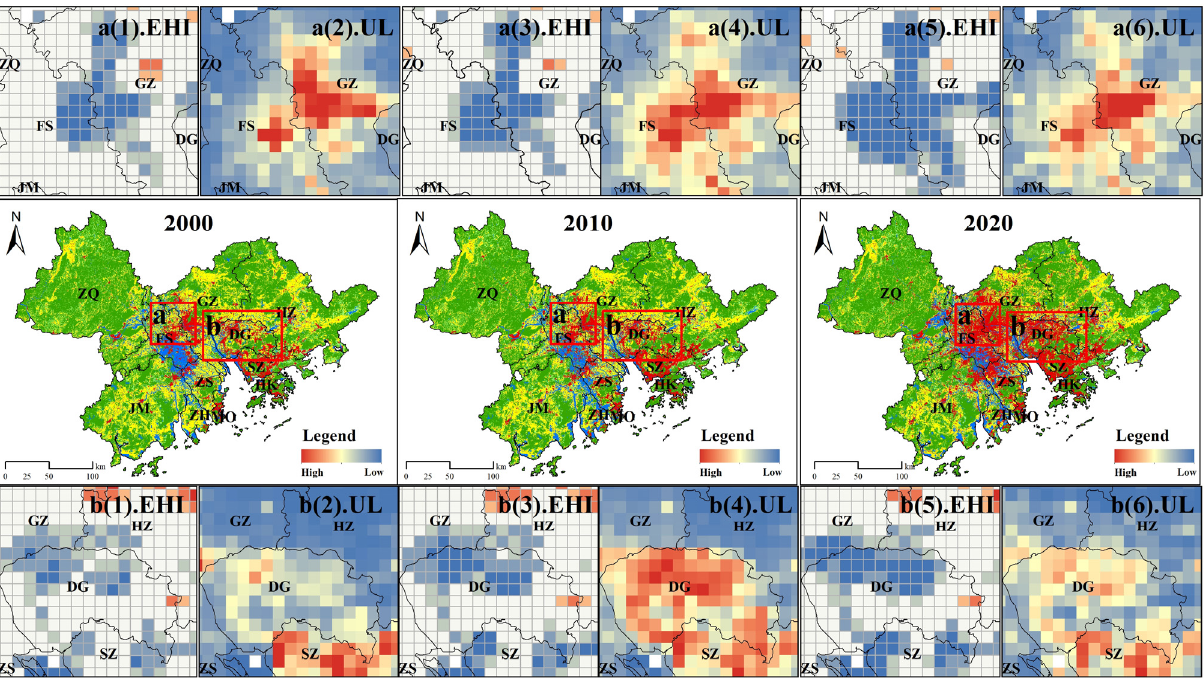
Figure 10. Changes in the EHI and UL in the core urban junction in the GBA, 2000–2020. Note: a(1) – a(6) , distribution of EHI and ULs cold spots in a regions, 2000–2020; b(1) – b(6) distribution of EHI and ULs cold spots in b regions, 2000–2020.